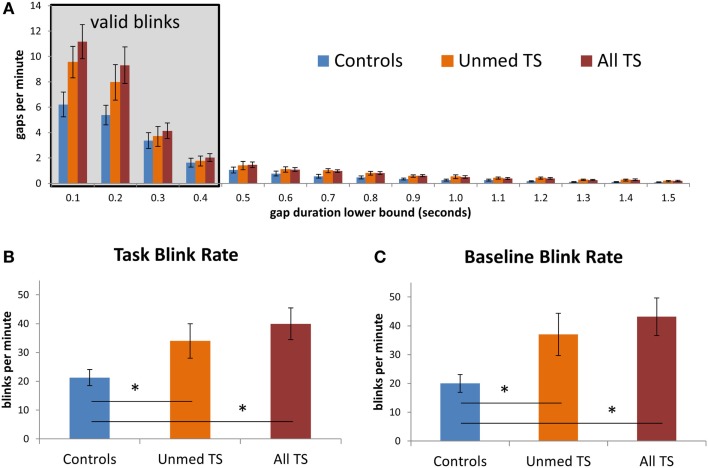
(A) Observed rate of gaps in the eyetracking data, at fixed intervals, for patients and controls. Values on the x-axis give the lower bound for each interval; the left-most interval includes gaps between 100 and 200 ms in duration, while the rightmost interval includes gaps between 1500 and 1600 ms. The shaded box indicates gaps that were considered to be valid blinks. Gaps of <100 ms were excluded from this graph. (B) Average blink rate during task blocks, in controls, unmedicated TS patients, and all TS patients. (C) Average blink rate during the 30-s baseline fixation period, for each group. Error bars indicate standard error of the mean. Asterisks denote p < 0.05.